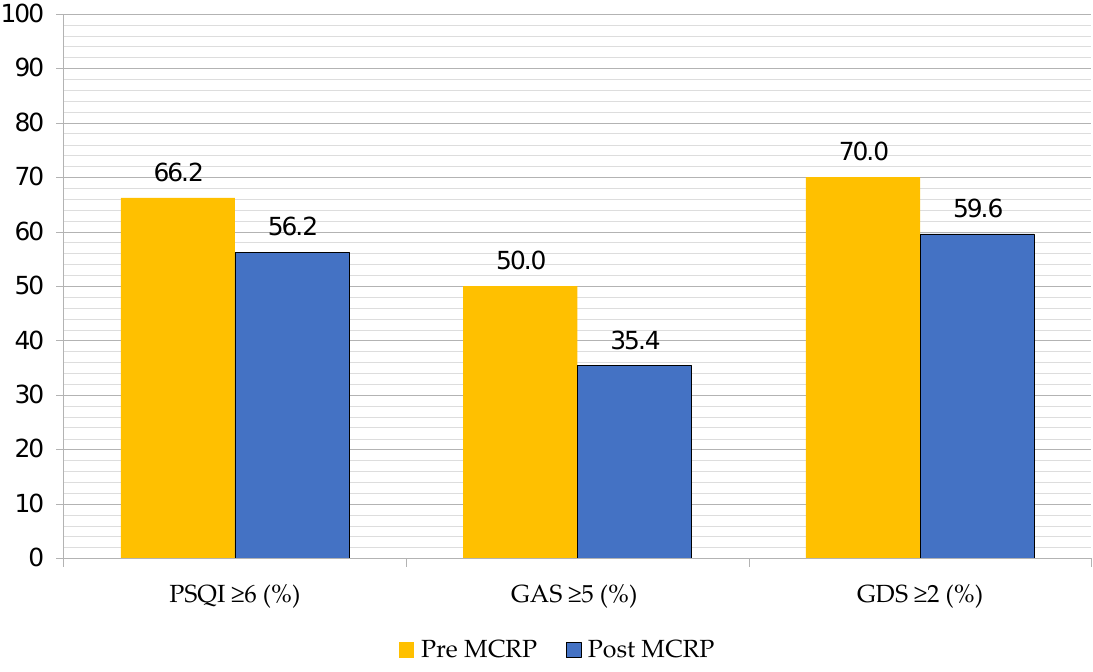
Figure 1. Prevalence (%) of poor sleep quality (PSQI ≥ 6), anxiety (GAS ≥ 5), and depression (GDS ≥